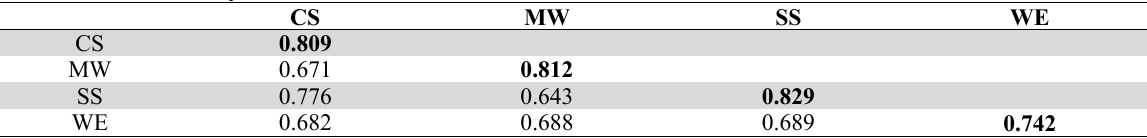
Discriminant Validity CS MW SS WE CS